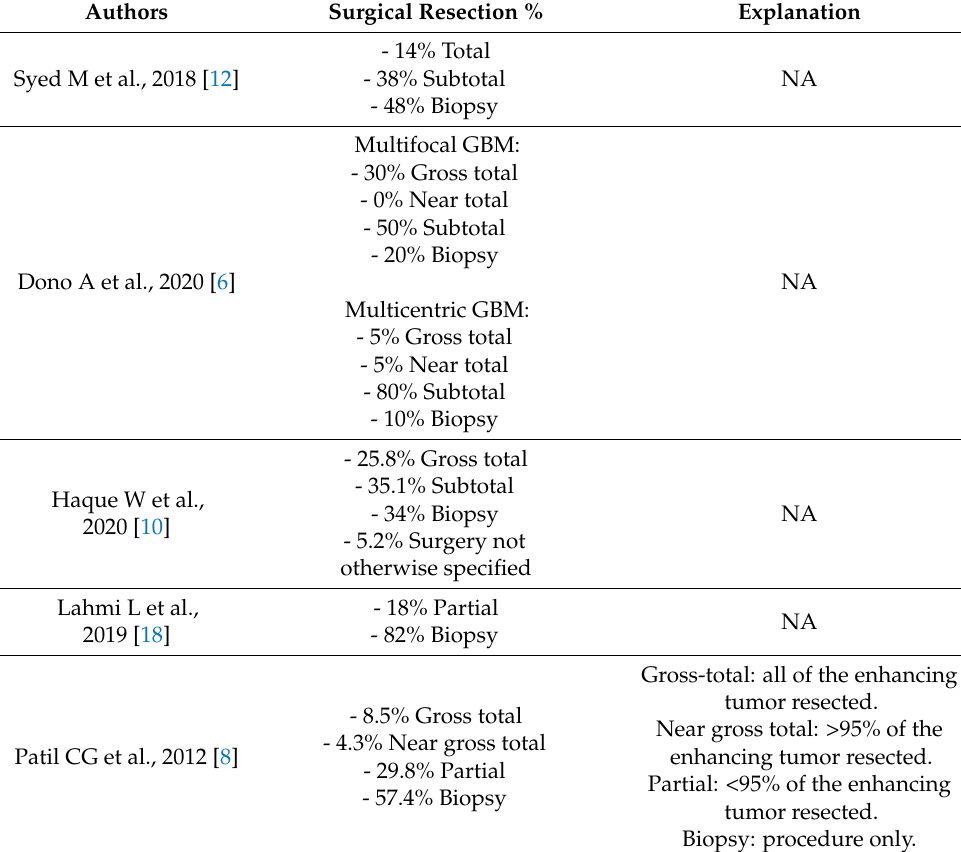
Table 8. Data on the extent of resection in mGBM. Explanations are reported when